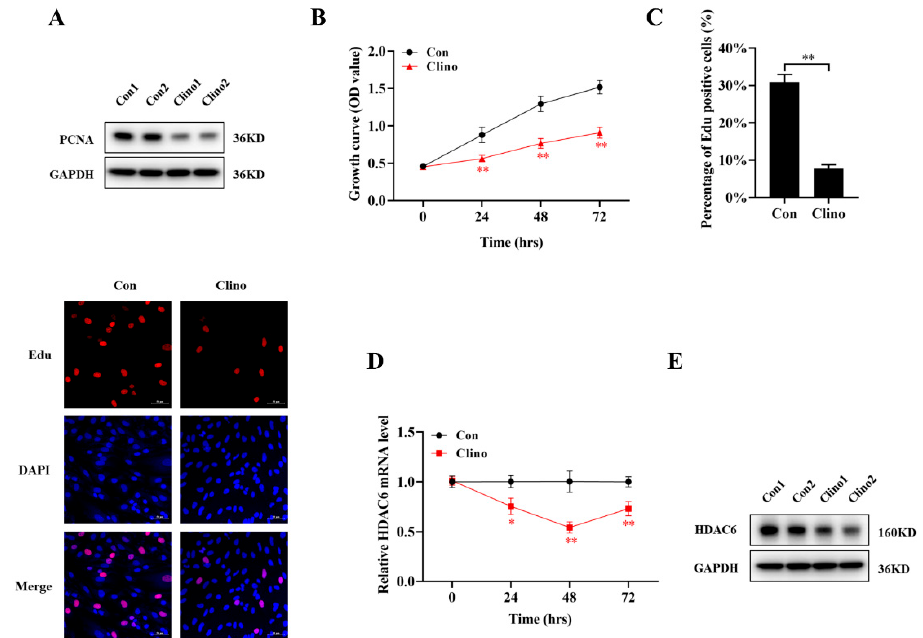
Figure 1. Mechanical unloading inhibits microvascular endothelial cell proliferation and downreg- ulates HDAC6 expression. ( A ) Protein expression of PCNA was analyzed by Western blotting in microvascular endothelial cells that were cultured under clinorotation conditions for 48 h (N = 3). ( B ) Cell proliferation was evaluated by a CCK-8 assay at 24–72 h (N = 3). ( C ) The EdU incorporation assay was analyzed by confocal microscopy. Proliferating microvascular endothelial cells were labeled with EdU. Microvascular endothelial cells were stained with the nucleic acid dyes Hoechst (blue) and EdU (red) (N = 3). Scale bar, 50 µ m. ( D ) HDAC6 mRNA expression was assessed in microvascular endothelial cells under clinorotation conditions for 24, 48 and 72 h (N = 3). ( E ) The HDAC6 protein level was analyzed by Western blotting (N = 3). * p < 0.05, ** p < 0.01 vs. control.